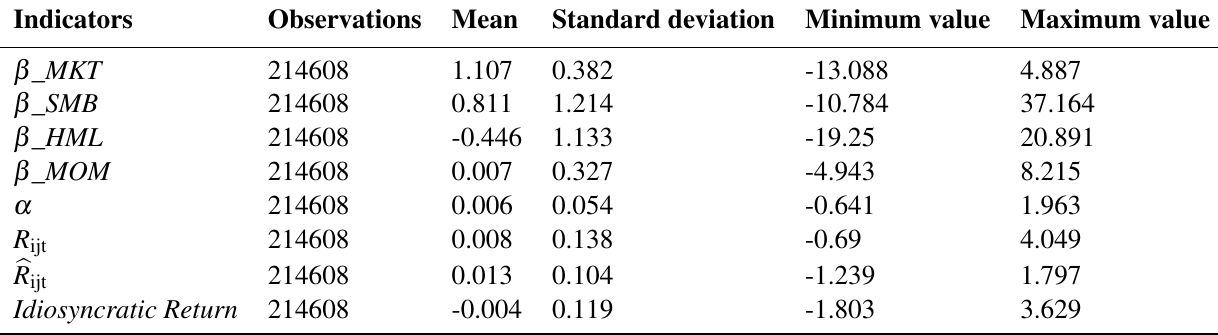
Table 1 Carhart four-factor model regression descriptive